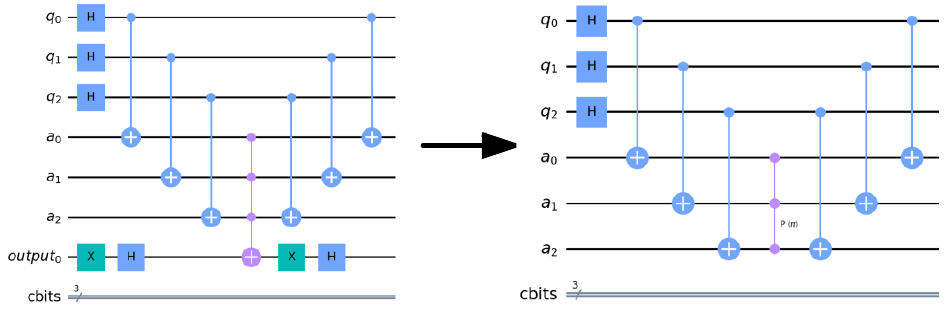
Figure 7. Using phase quantum gate.